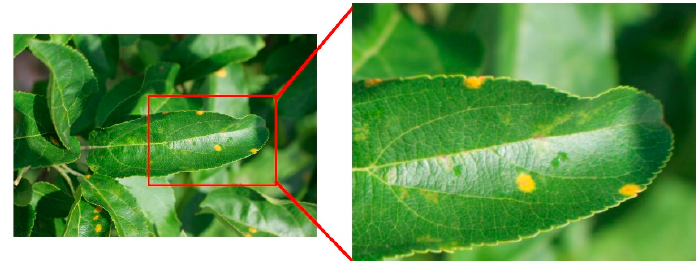
Figure 8. Leaf with cedar apple rust.